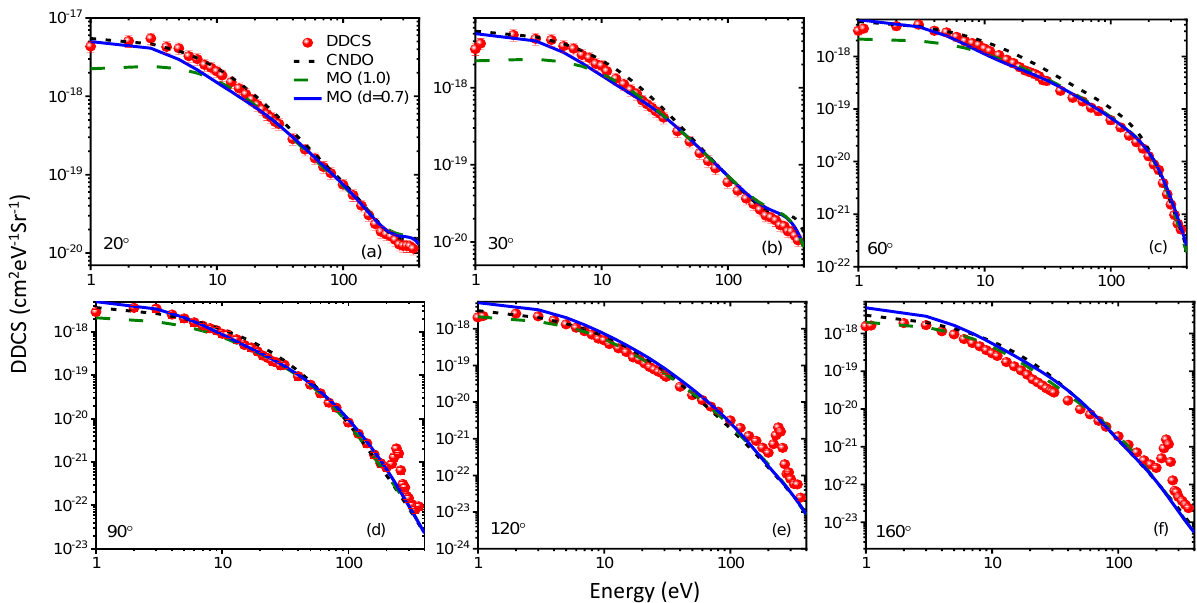
Figure 1. Energy distributions of DDCS (red circles) along with different theoretical calculations for several scattering angles. The solid, dashed and dotted lines are CDW − EIS (MO) ( d = 1), CDW − EIS (MO) ( d = 0.7) and CDW − EIS (CNDO),